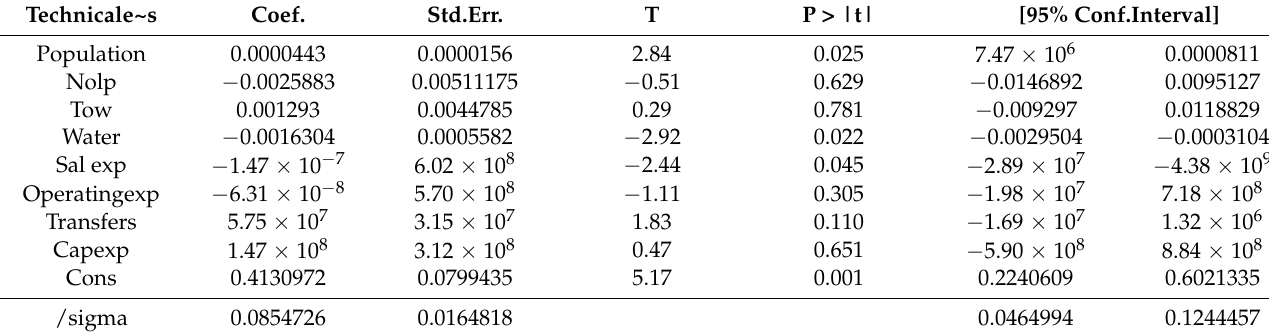
Table 12. Tobit Results 2004.